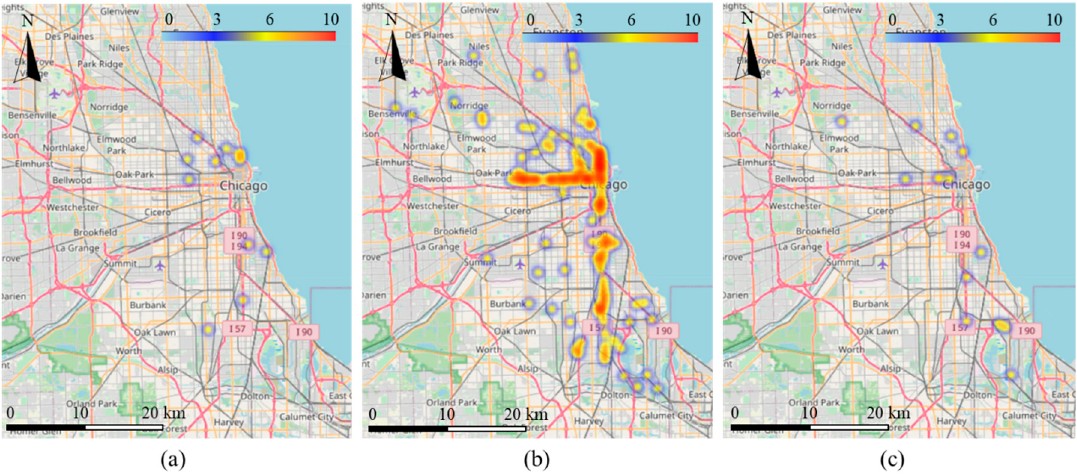
Figure 8. Hotspots of burglary in New York City, NY ( a ) 26 May 2020; ( b ) 2 June 2020; ( c ) 9 June 2020.